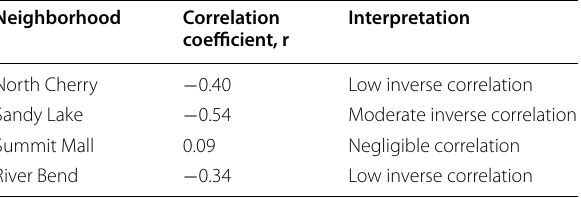
Table 3 Correlation between sidewalk and greenness density Neighborhood Correlation coefficient,